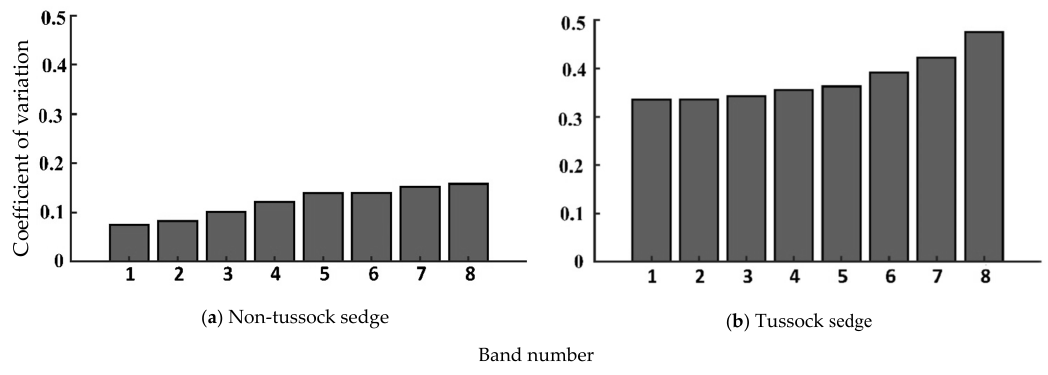
Figure 6. Coefficient of variation for the multispectral band datasets. Figure 6. Coe ffi cient of variation for the multispectral band datasets.